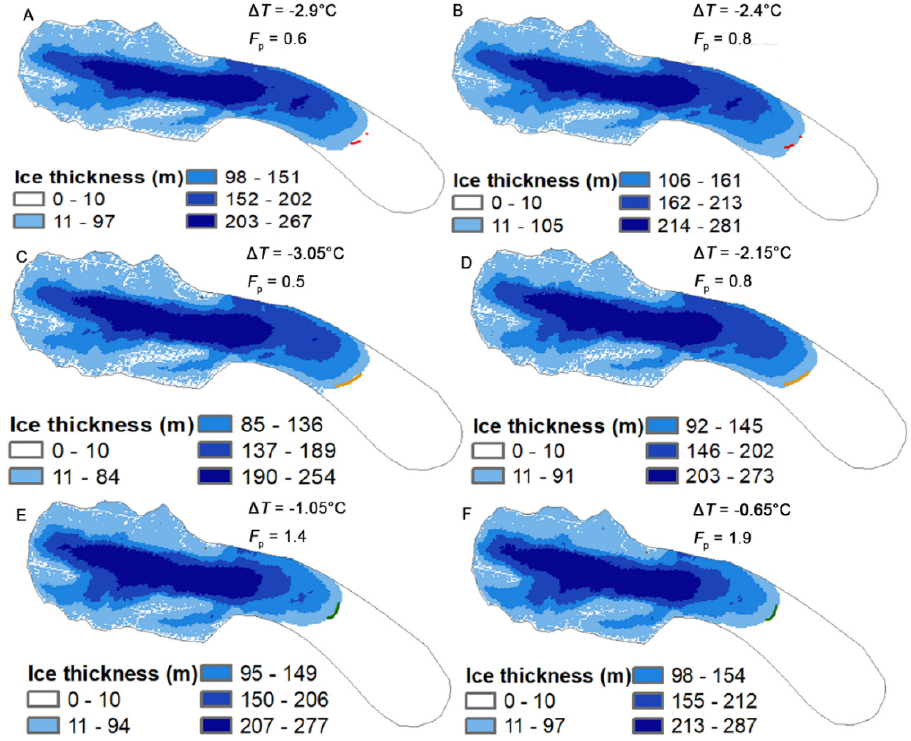
Figure 5. Selected modelled glacial extents during ( A , B ) the early MIS 2, ( C , D ) the LGM, and ( E , F ) the early Holocene. Frontal moraines representing glacial snouts during the early MIS 2 (M10), LGM (M9), and early Holocene (M8) are labelled in red, orange, and green, respectively.